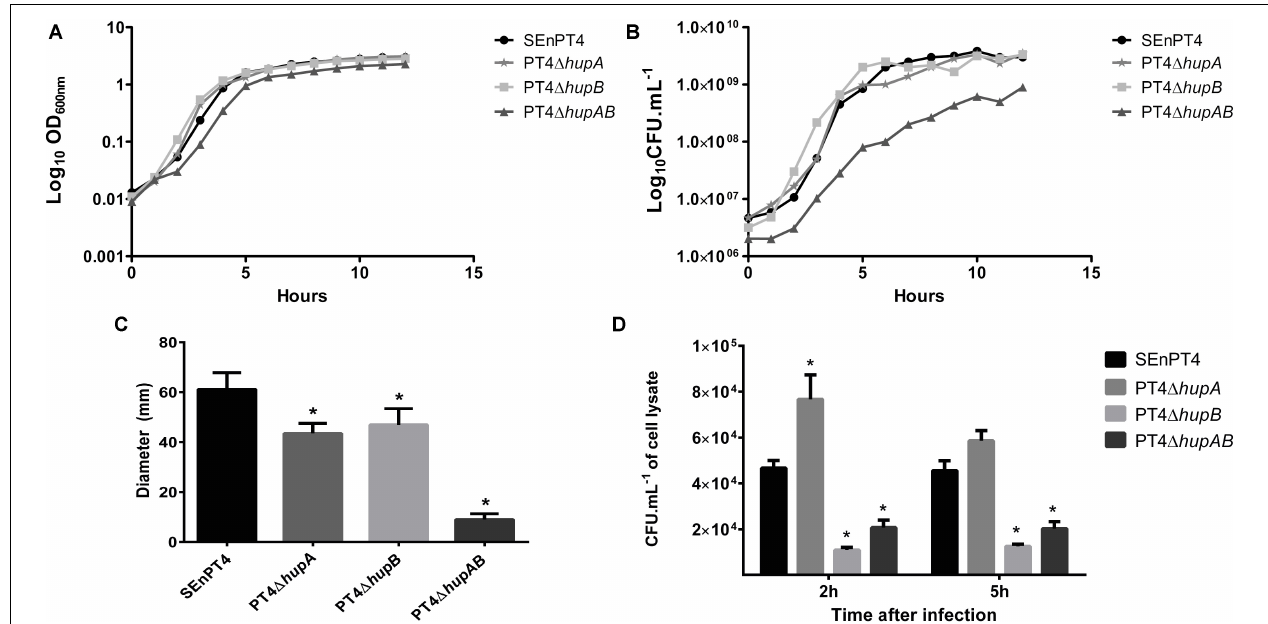
FIGURE 1 | In vitro phenotypes of HU-lacking mutants. The growth of all mutant strains and wild-type parental strain SEnPT4 was measured every hour for 12 h by OD 600 readings (A) or CFU counts (B) . The growth curves represent the results of three independent experiments. (C) The motility capacity of the mutants was also evaluated in 0.35% agar plates, measured after 14 h of incubation. (D) J774A.1. macrophages were infected in vitro with HU mutants and SEnPT4 parental strains. Graphs show the number of colony forming units (CFUs) of intracellular bacteria recovered at 2 and 5 h after infection. Values of motility and macrophage assay are represented as mean ± SEM of quintuplicate samples of three independent experiments. ∗ P < 0.01 by Tukey’s test as compared to SEnPT4.